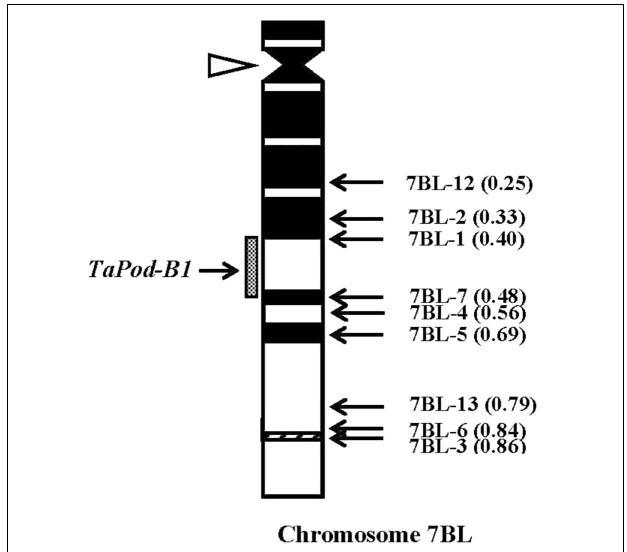
FIGURE 7 | Physical map of Chinese Spring (CS) chromosome 7BL. The identification of deletion lines and fraction arm length (FL) values of breakpoints ( parentheses ) is shown on the right . C-banding patterns of chromosomes are taken from Gill et al. (1991). The chromosomal region ( gray hatched bar ) from FL = 0.40 to FL = 0.48 indicates the putative location of the TaPod-B1 gene. Chromosome long arms point toward the bottom and the open arrow ( left ) shows the position of the